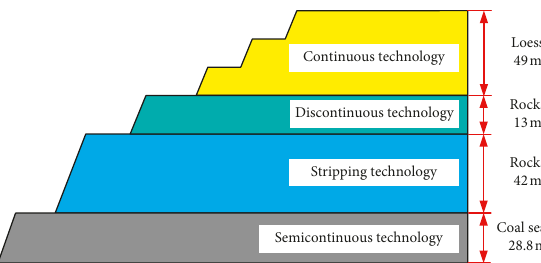
Figure 3: Application of various production technologies. Table 1: Stratigraphic column through cast-blasting